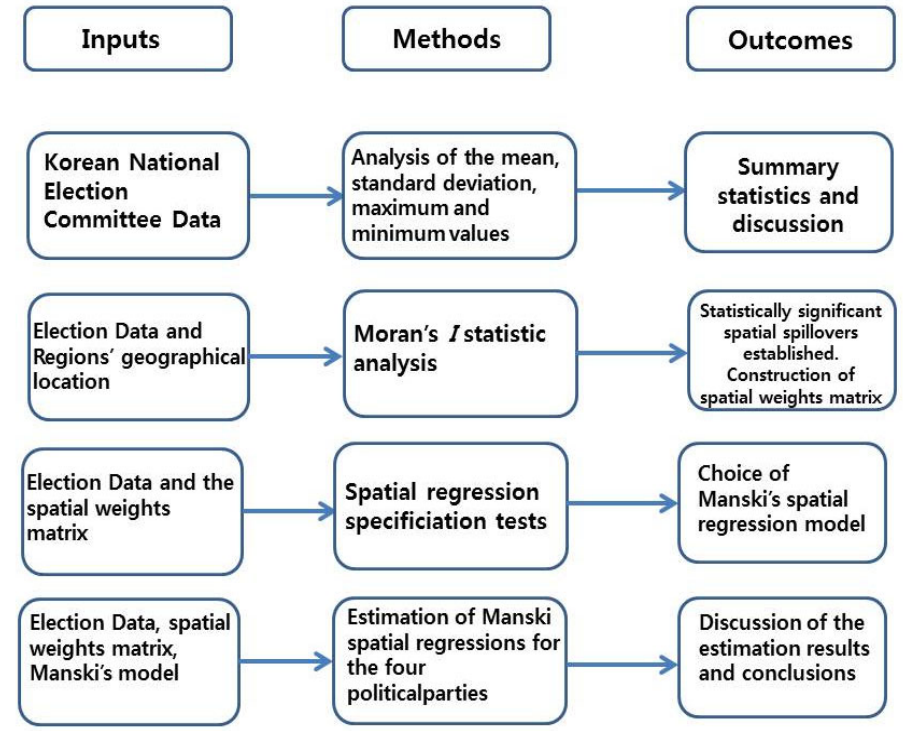
Figure 4. Research Flow.